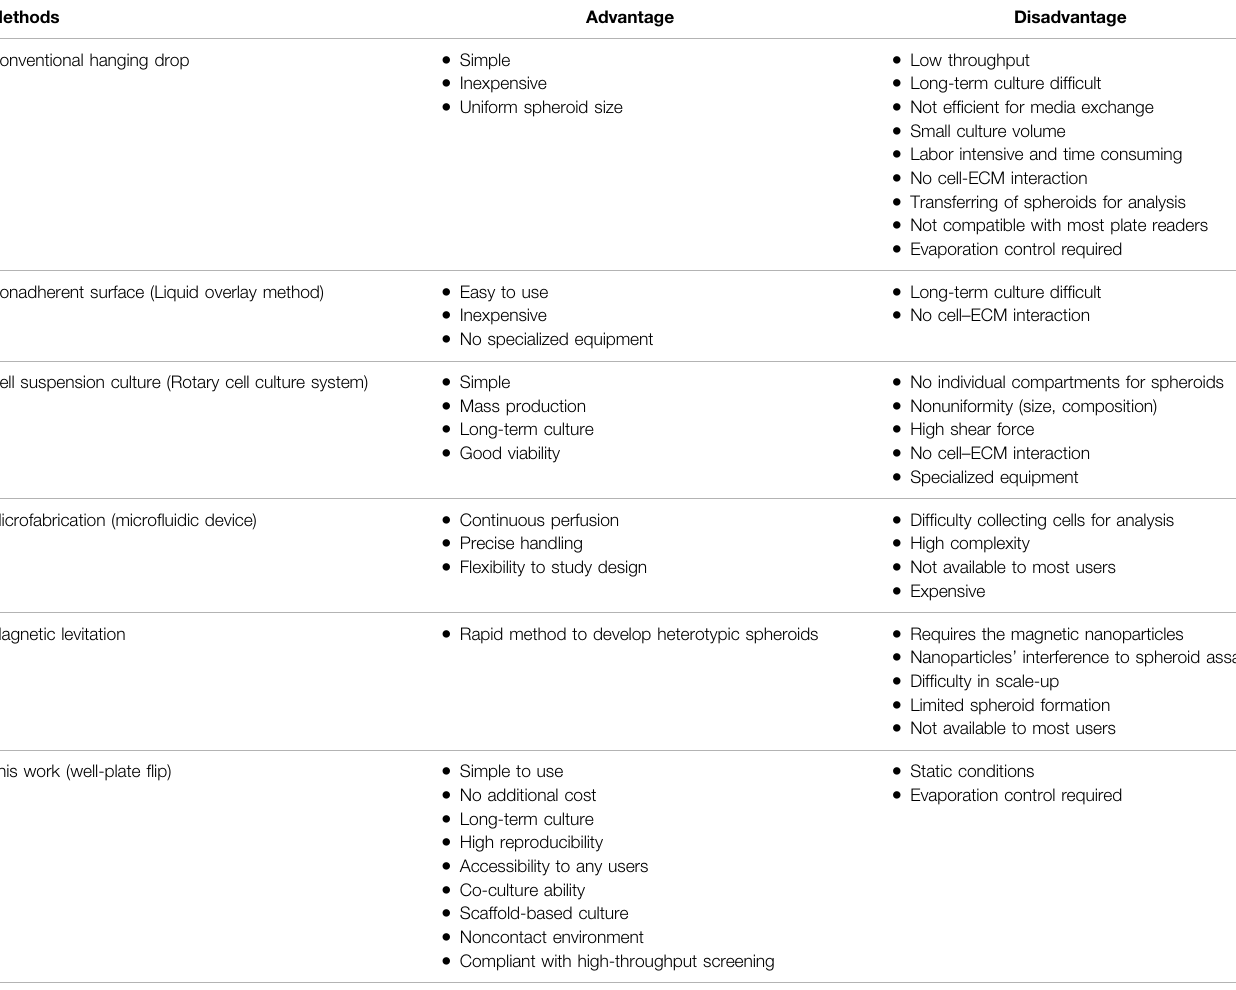
TABLE 1 | Summary of spheroid formation techniques along with advantages and disadvantages.